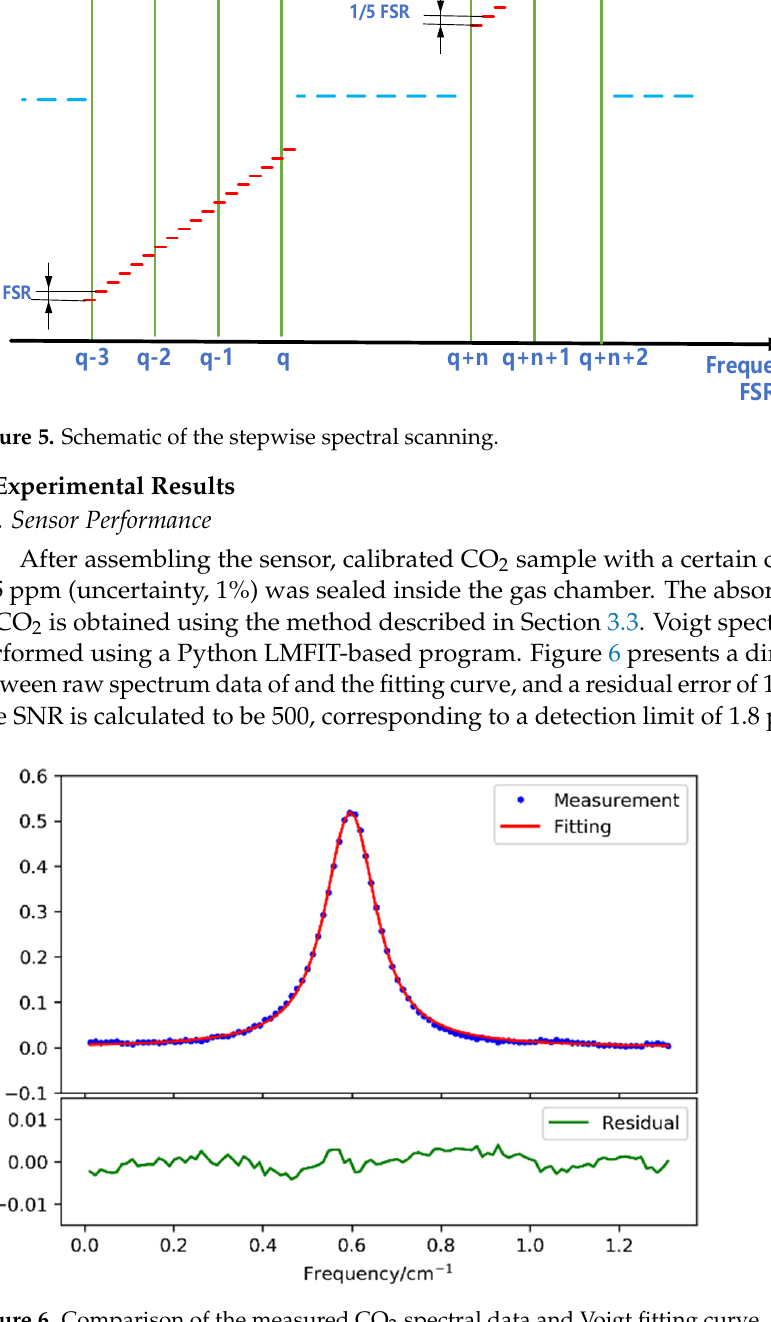
Figure 6. Comparison of the measured CO 2 spectral data and Voigt fitting curve. CO 2 samples with different concentration of 2000 ppm, 1600 ppm, 1000 ppm, 500 ppm and 250 ppm were generated by diluting the calibrated 10000 ppm CO 2 with pure N 2 . The uncertainty for above samples is 1%, mainly introduced by the dilution system. The mass flow meter was used to control the inlet flow rate at 50 mL/min. A continuous measurement of each CO 2 sample was performed over 45 min and the experimental results are shown in Figure